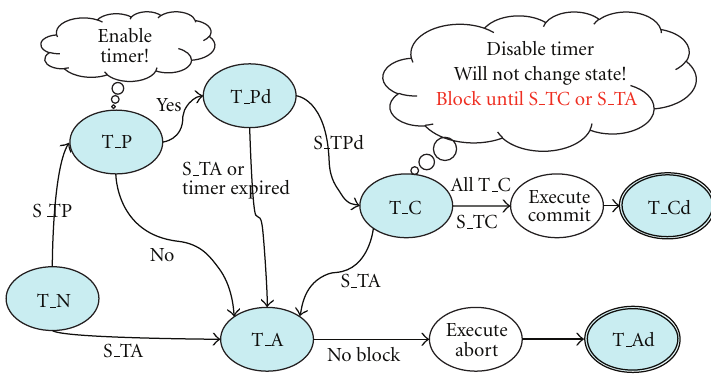
Figure 2: The TDC transition